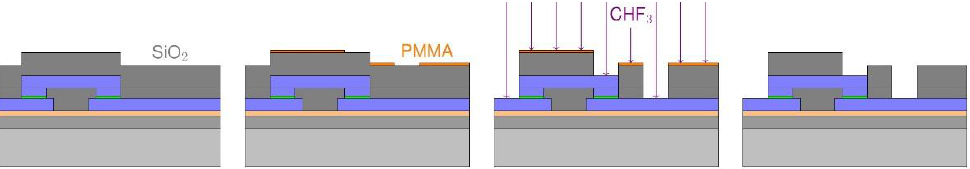
Figure 4. Layer scheme of the nanoSQUID fabrication process to etch windows (vias) into SiO 2 to connect the Nb layers. SiO 2 is deposed on top of the structure via PECVD and protected by a patterned positive resist mask during ICP RIE with CHF 3 .